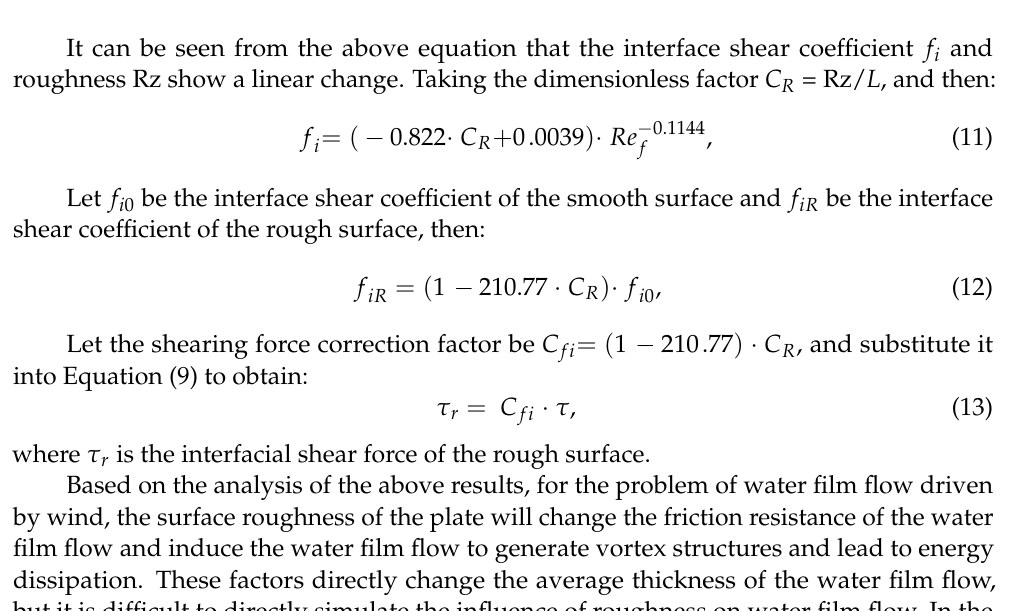
changed to adapt to different fitting curves.